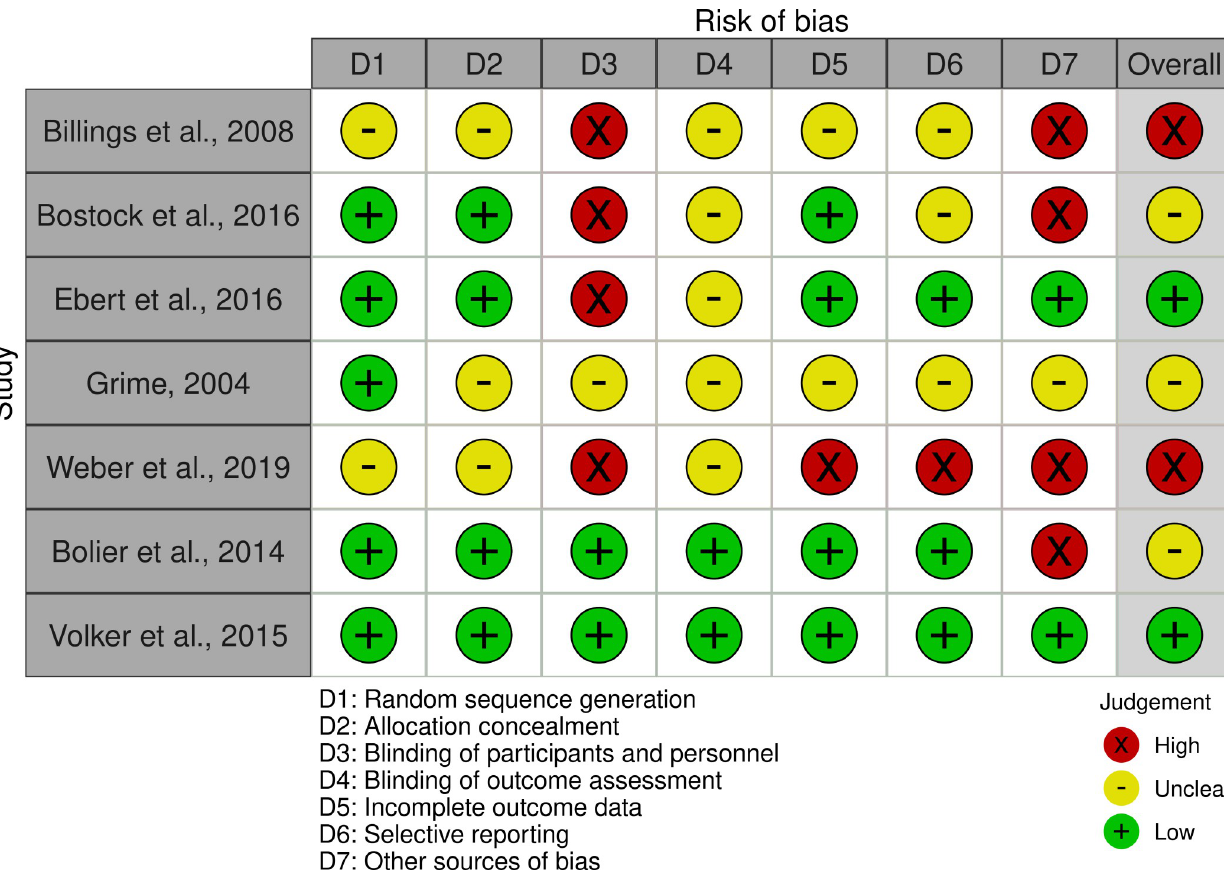
Fig 2. Risk of Bias Visualization